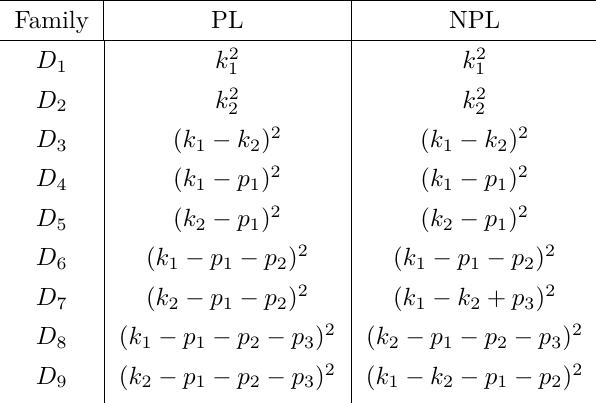
Table 2 . Planar and non-planar 2-loop integral families.